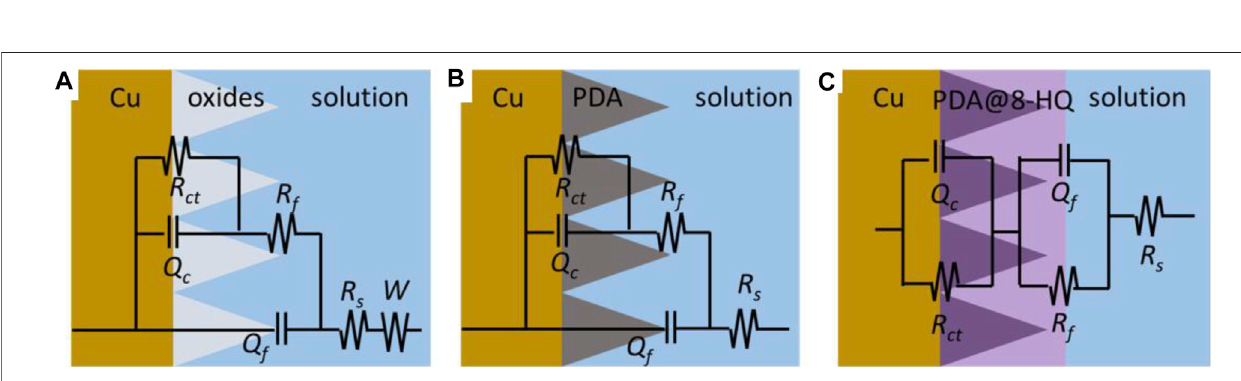
FIGURE 5 | Bode (A) and phase angle (B) plots for different copper samples recorded in 3.5 wt.% NaCl aqueous solution.